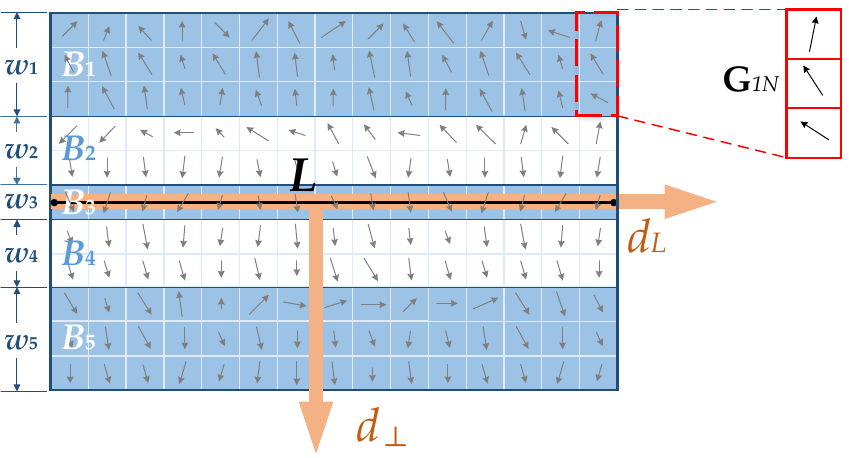
Figure 3. Illustration of the banded sub-regions of line segment L . The small arrows represent the gradients of the pixels. The direction d ⊥ is defined as the average gradient orientation of all the pixels on segment L , and the direction d L is defined as the counterclockwise orthogonal direction of d ⊥ . The entire support region is divided into m banded sub-regions with gradually changing